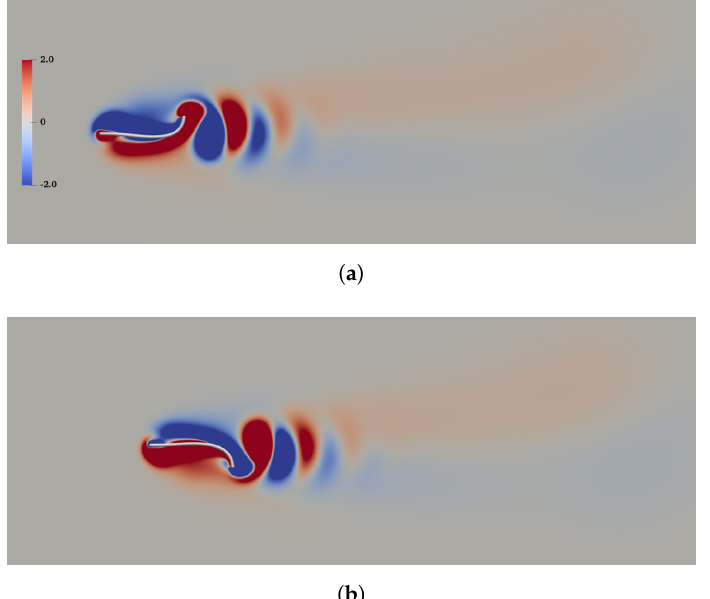
Figure 5. Vorticity contours and shapes of the swimmer with the trailing edge located at the highest ( a ) and lowest ( b ) vertical